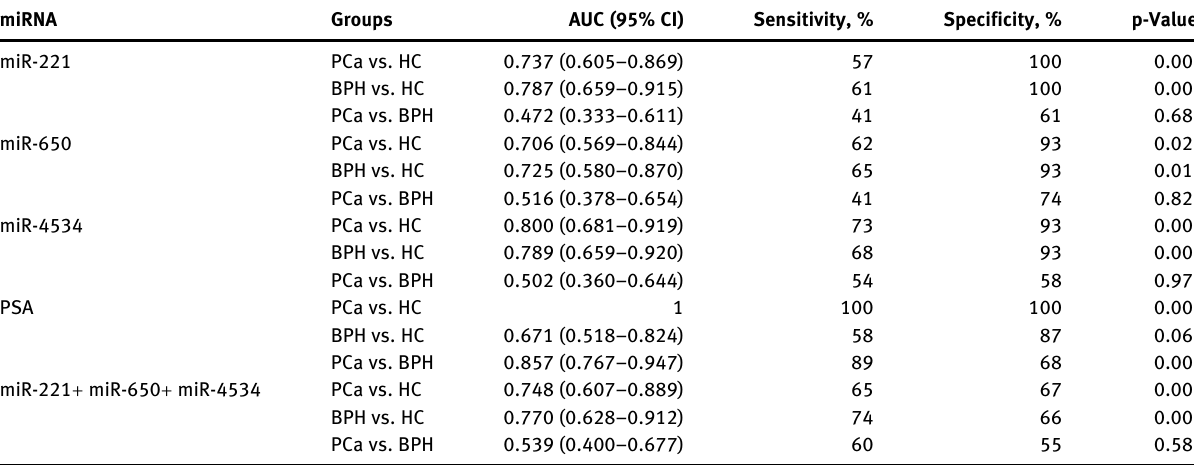
Table  : Diagnostic ef fi ciency of miRNAs and PSA in the discriminating of patient groups.